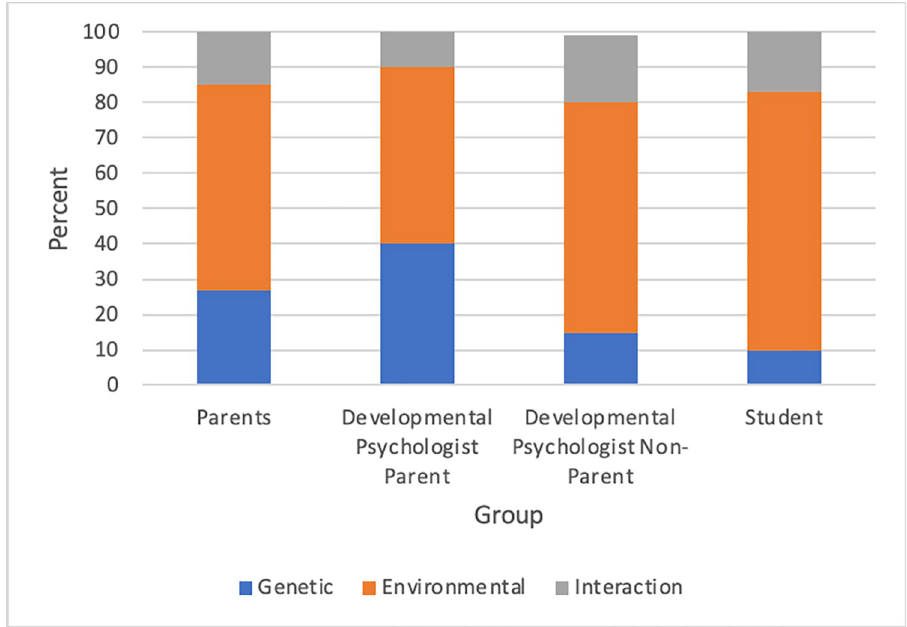
Fig 4. Participant responses on the etiology of development by